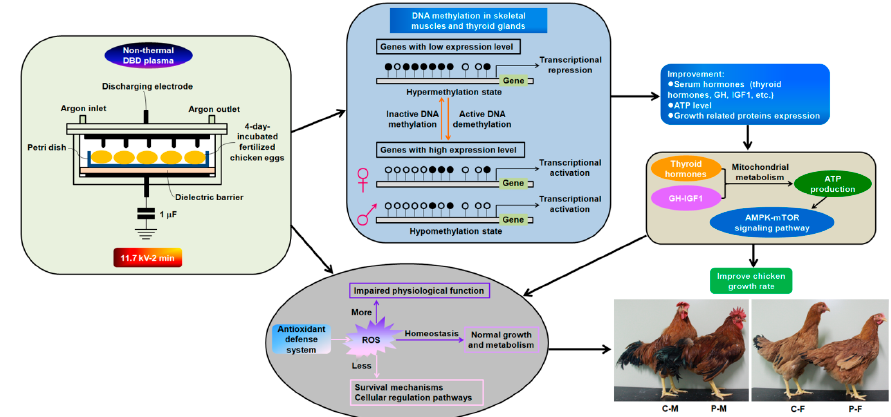
Data are presented as mean ± standard deviation (SD) ( n = 20) of three replicates; n represents an individual chicken. Within a column: different lowercase letters indicate significant differences ( p < 0.05) in females and males, respectively, according to the one-way ANOVA with a least significant difference (LSD) test.